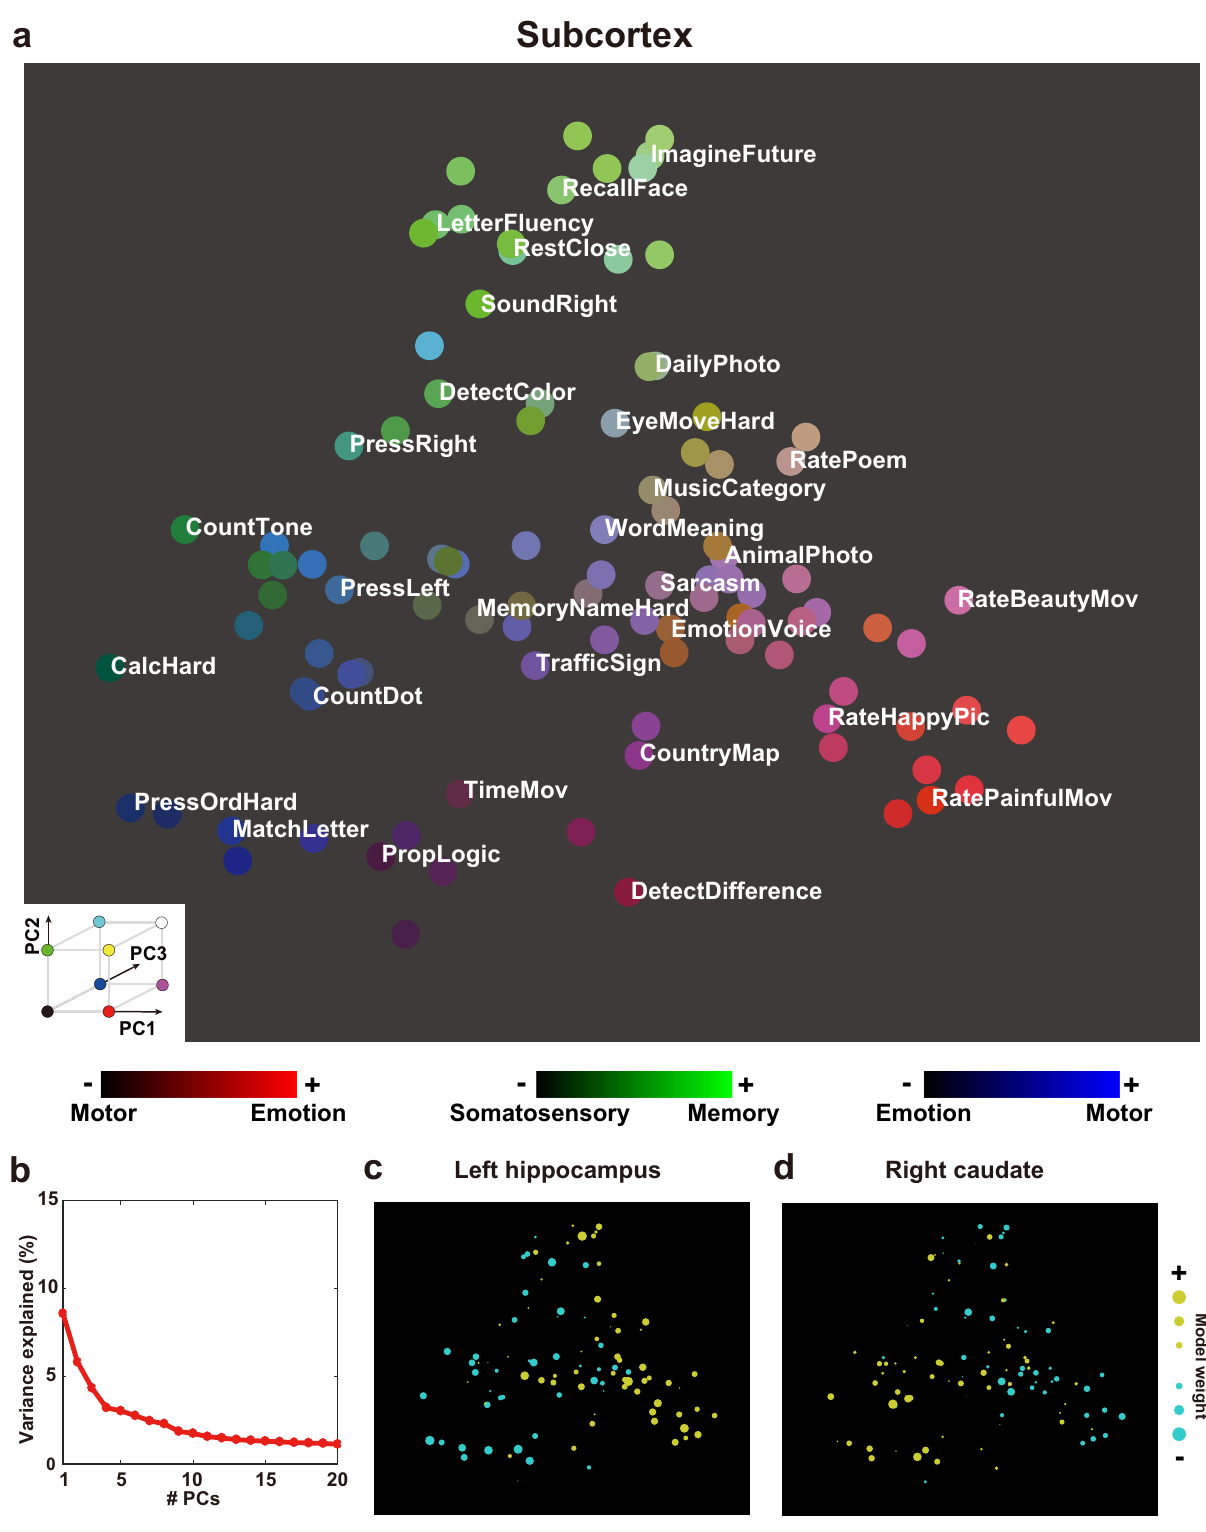
Fig. 4 Visualization of task structures in the subcortex. a Color and spatial visualization of the cognitive space. Colors indicate the normalized loadings of the top three principal components [PC1, red; PC2, green; PC3, blue] of the task-type model weights (concatenated across subjects), mapped onto the two- dimensional cognitive space based on the loadings of PC1 and PC2. Each PC is labeled based on metadata-based interpretation analysis (Supplementary Table 3). All tasks are presented in white letters. For a better visibility, only 30 tasks are shown in white. b Variance explained in the PCA. The explained variance of the original weight matrix of the task-type model was plotted for each PC. c – d Examples of task selectivity for subcortical voxels in the c left hippocampus and d right caudate, mapped onto the same two-dimensional cognitive space as a for subject ID01. Tasks with positive and negative weight values in c and d were indicated in yellow and cyan, respectively. The circle size was modulated based on the absolute weight